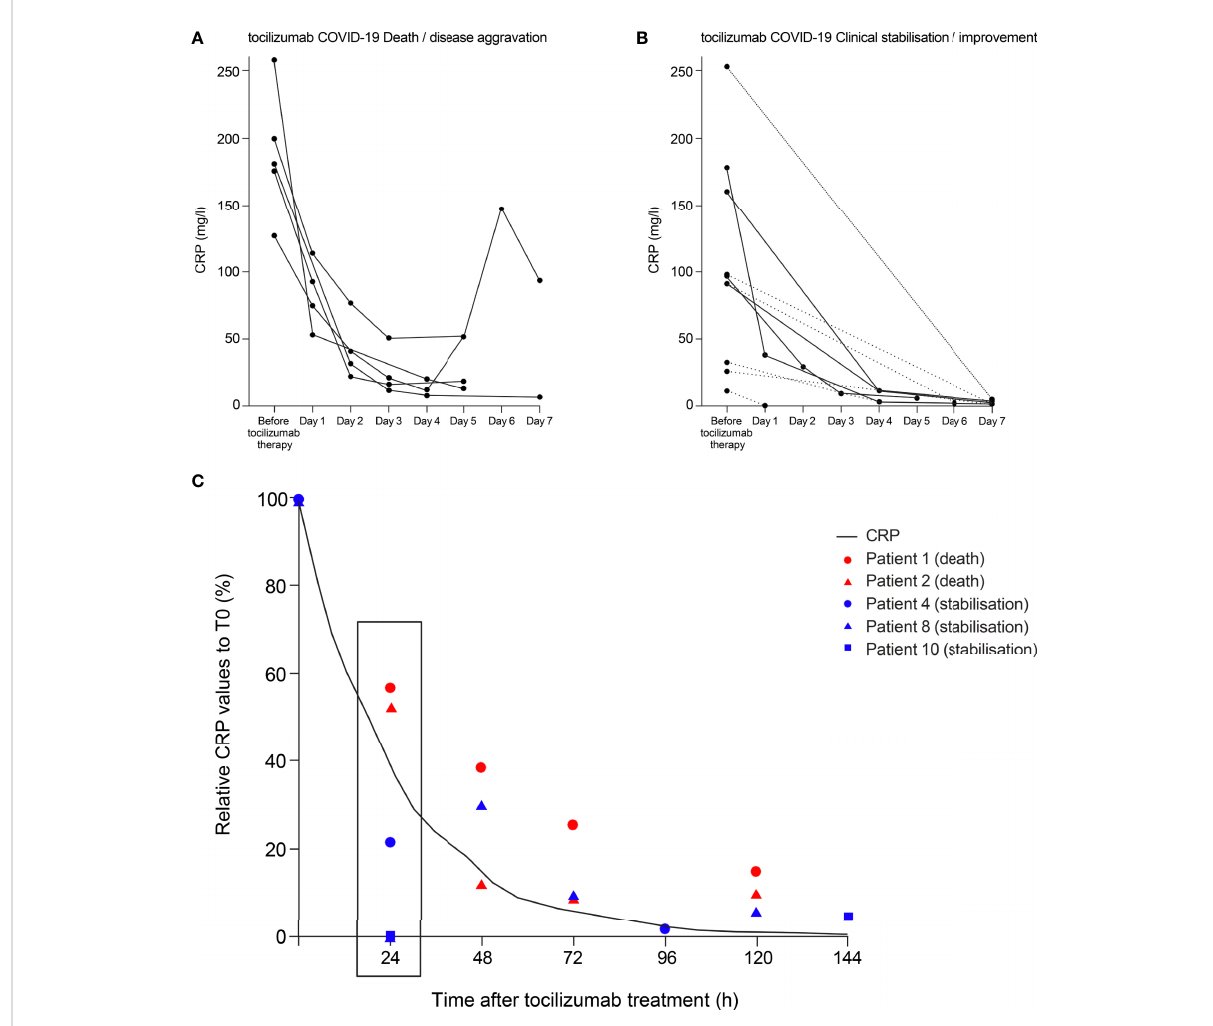
FIGURE 4 Theoretical curve for CRP inhibition to achieve complete IL-6 blockade compared with CRP levels in patients with COVID-19 treated with tocilizumab. CRP data points from patients with COVID-19 treated with tocilizumab in the study of Luo and colleagues (1) are shown. Individual data points are plotted for CRP values from (A) patients who died or experienced disease aggravation following tocilizumab treatment and (B) patients who experienced clinical stabilisation or improvement following tocilizumab treatment. CRP levels were not measured at every time point for every patient. Two patients died on day 6 and one patient died on day 7; the last CRP measurements for these patients were at day 5. For patients with fewer than three CRP measurements, data points are joined with a dotted line. (C) Relative CRP values to the initial concentration are depicted for patients who had several CRP measurements. Patients who died following tocilizumab treatment are shown in red and those whose condition stabilised are shown in blue. The curve plotted shows the percentage of ideal CRP reduction that re fl ects a complete block of IL-6, taking into account its half-life of 18 hours. CRP, C-reactive protein; IL-6, interleukin-6; T0, time